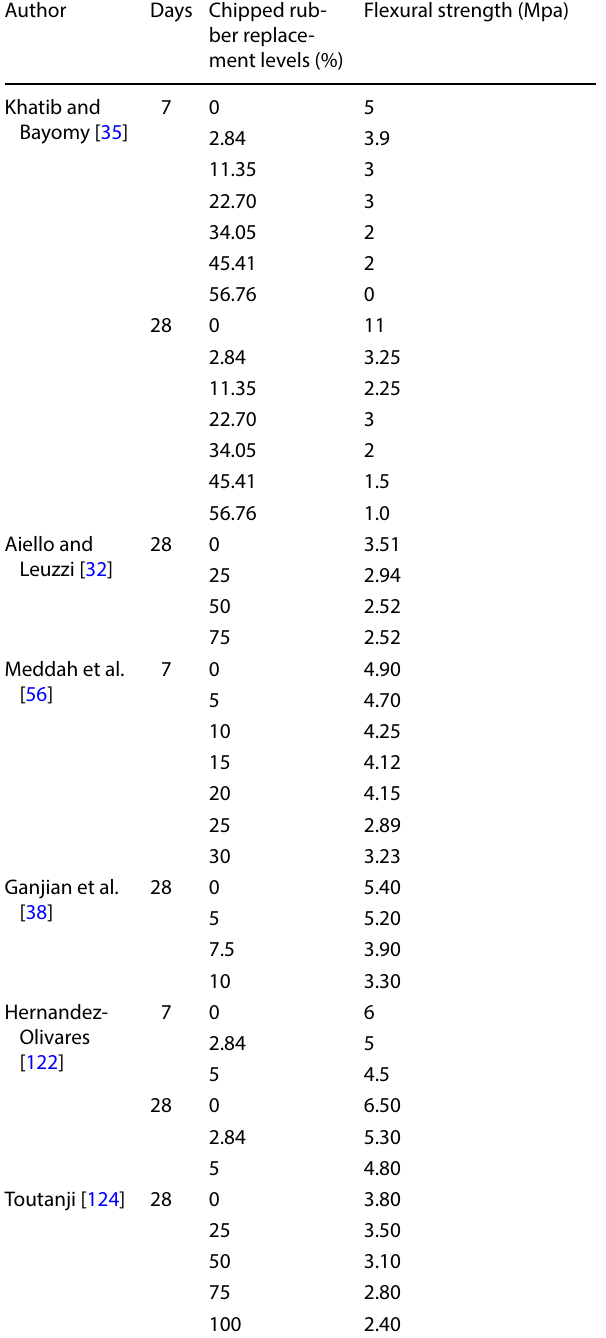
Table 4 Flexural strength (MPa) of chipped rubbercrete Author Days Chipped rub- ber replace- ment levels